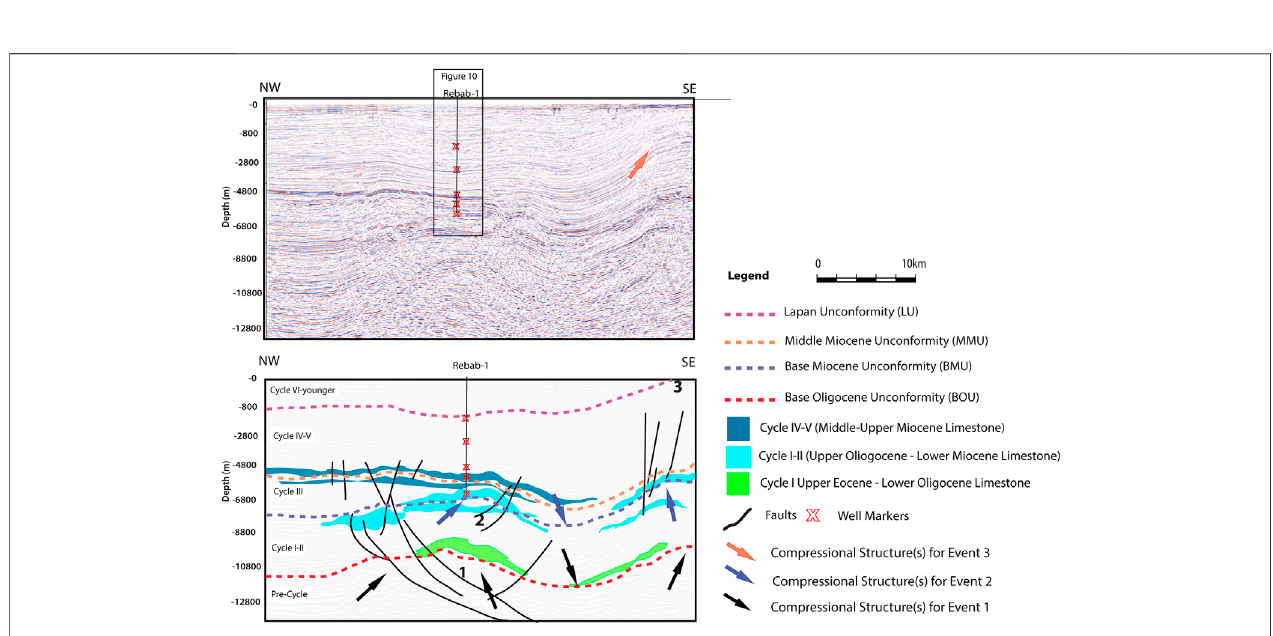
FIGURE 7 | Seismic line oriented in NW-SE, crossing Rebab-1 well. Interpretation of Middle Miocene limestone is based on the well-seismic correlation and guidance of geophysical characteristics of the re fl ectors. The Upper Oligocene and Upper Eocene limestone are interpreted based on the geophysical characters. Location of the line is shown in Figure 1B . Annotation 1 – 3 are referring to Event 1 – 3 discuss in this paper.